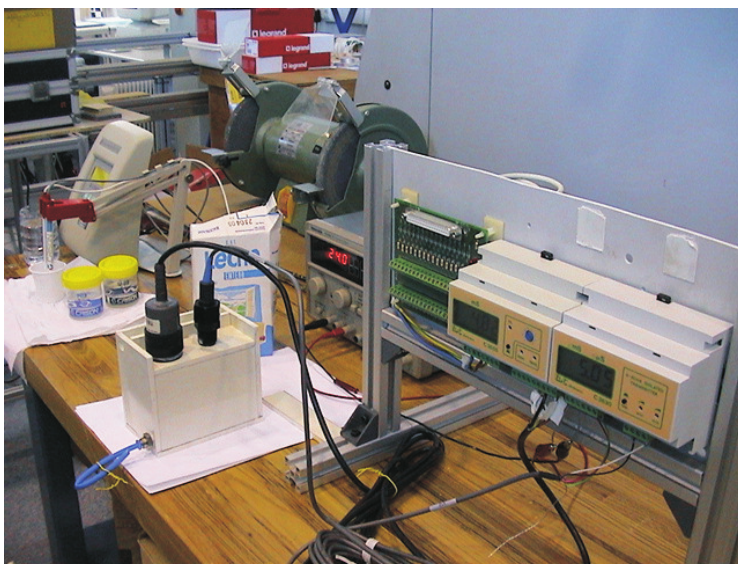
Figure 5. Off-line testbed for evaluation of probes. At rear is the laboratory EC probe and in front are C1 and C2 probes inserted at one measurement